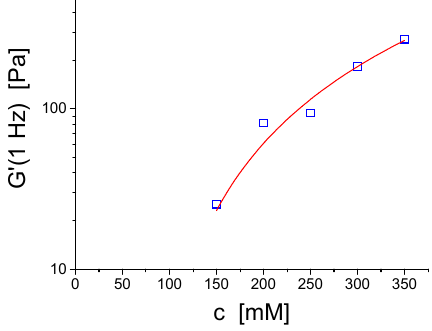
Figure 6. Storage modulus G ′ as a function of total concentration for vesicles gels composed of Brij30 (technical grade C 12 E 4 ) and 4 mol % DTAB, solid line: G ′ (1 Hz) = A × (c − c 0 ) x ; c 0 = 76 mM, x = 1.87.